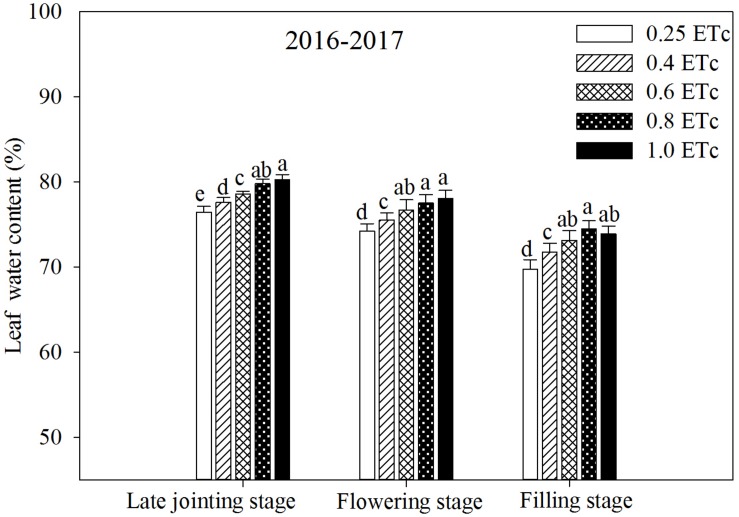
Leaf water content of winter wheat under different irrigation treatments (2016–2017). Vertical bars represent standard errors (n = 4). Different lowercase letters above the bars in the same growing stage are significantly different among different treatments at P < 0.05. The 0.25, 0.4, 0.6, 0.8, and 1.0 ETc represents 25, 40, 60, 80, and 100% crop evapotranspiration, respectively.